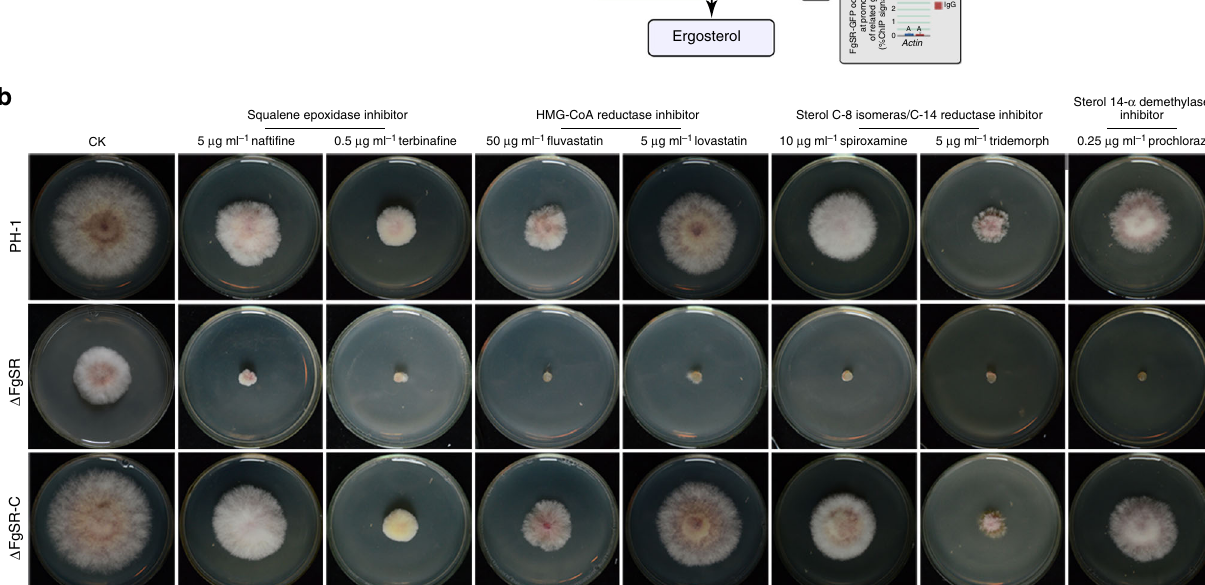
NATURE COMMUNICATIONS| (2019) 10:1228